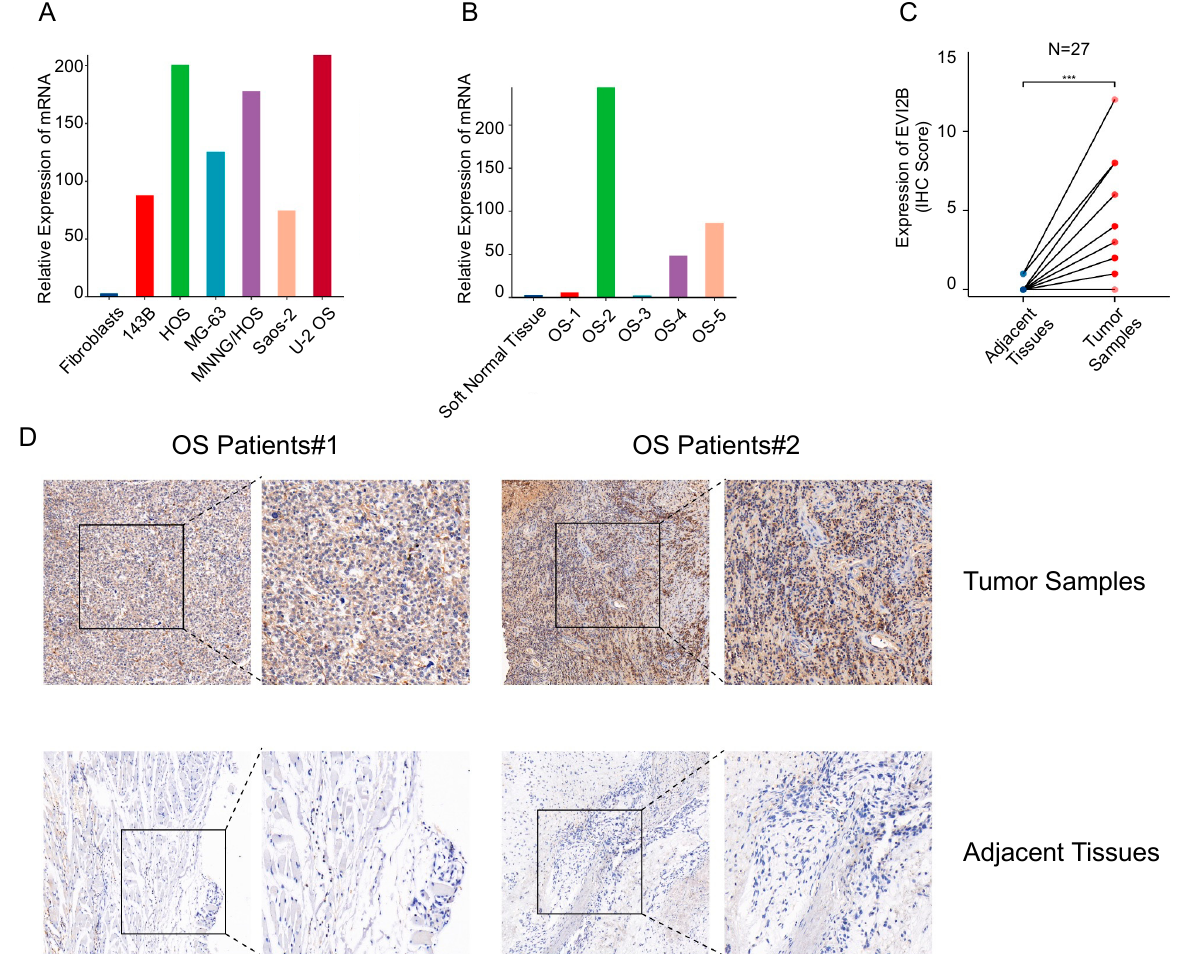
Figure 7. EVI2B expression in osteosarcoma cell lines and tissue samples. ( A ) Comparison of mRNA expression levels between different OS cell lines and fibroblast cells. ( B ) Comparison of mRNA expression levels in five OS tissue samples and adjacent normal tissues. ( C ) Immunohistochemical scores for 27 paired OS tumor tissues and adjacent normal tissues. ( D ) Representative immunohistochemical results for tumor and normal tissues in two patients with OS. *** p < 0.001.